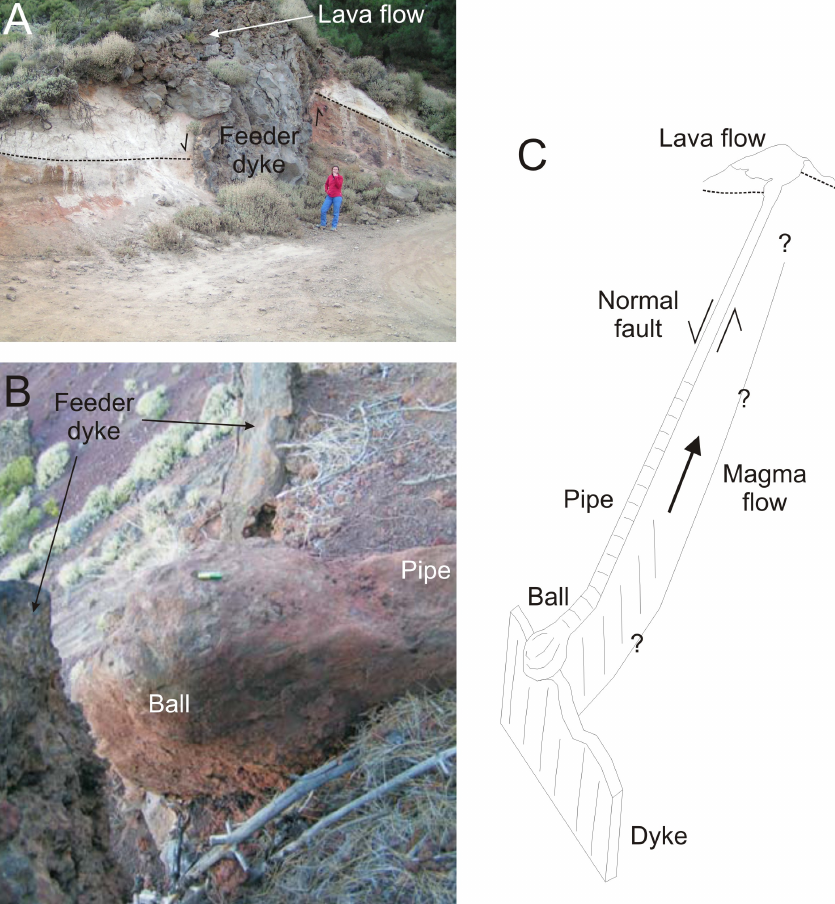
Fig. 9. (A) Outcrop of a shallow normal fault intruded by the Colorada feeder dyke (Tenerife), where the magma transported by the dyke extrudes and forms a small lava flow. No clear indicators have been found to suggest the reactivation of the fault due to the dyke intrusion. (B) Ball-shaped structure formed at the place where the feeder dyke cuts the fault. From the ball, a pipe structure propagates up to the fault. The main feeder-dyke trend is perpendicular to the fault plane (pipe). (C) Schematic illustration of the likely dyke propagation along the fault and to the surface to form the small lava